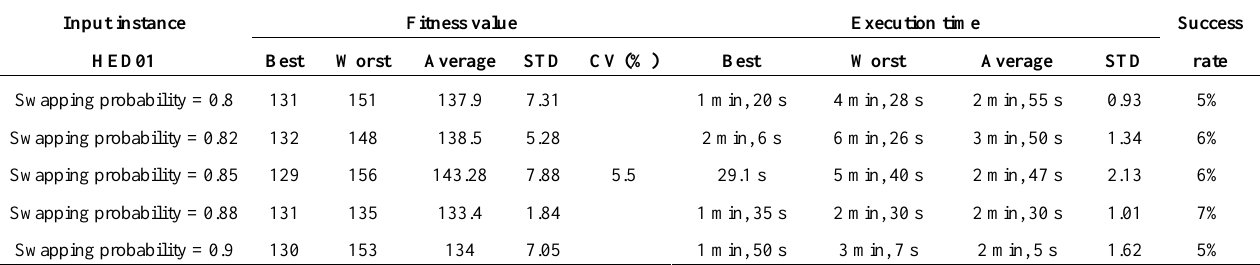
Table 25. Investigating the effect of swapping probability for input instance,